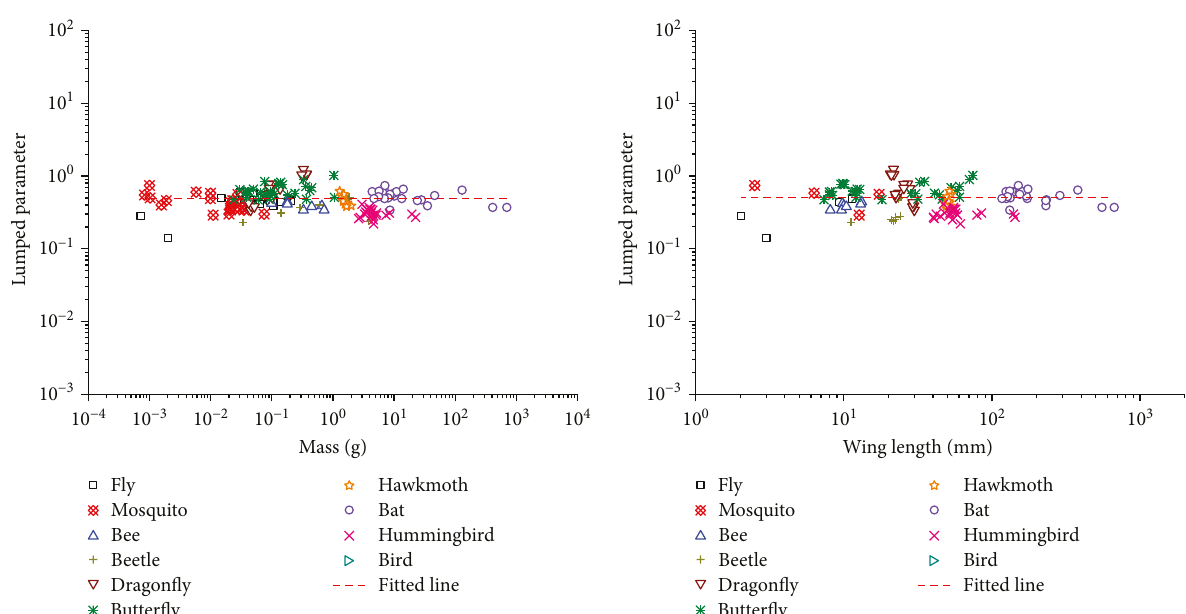
Figure 7: Relation of lumped parameter and mass (left), and lumped parameter vs. wing length (right) 1 . (1. The distribution of the data is lightly di ff erent in the two graphs because of absence of certain fi gures, which are indicated as “—” in Table 1.)